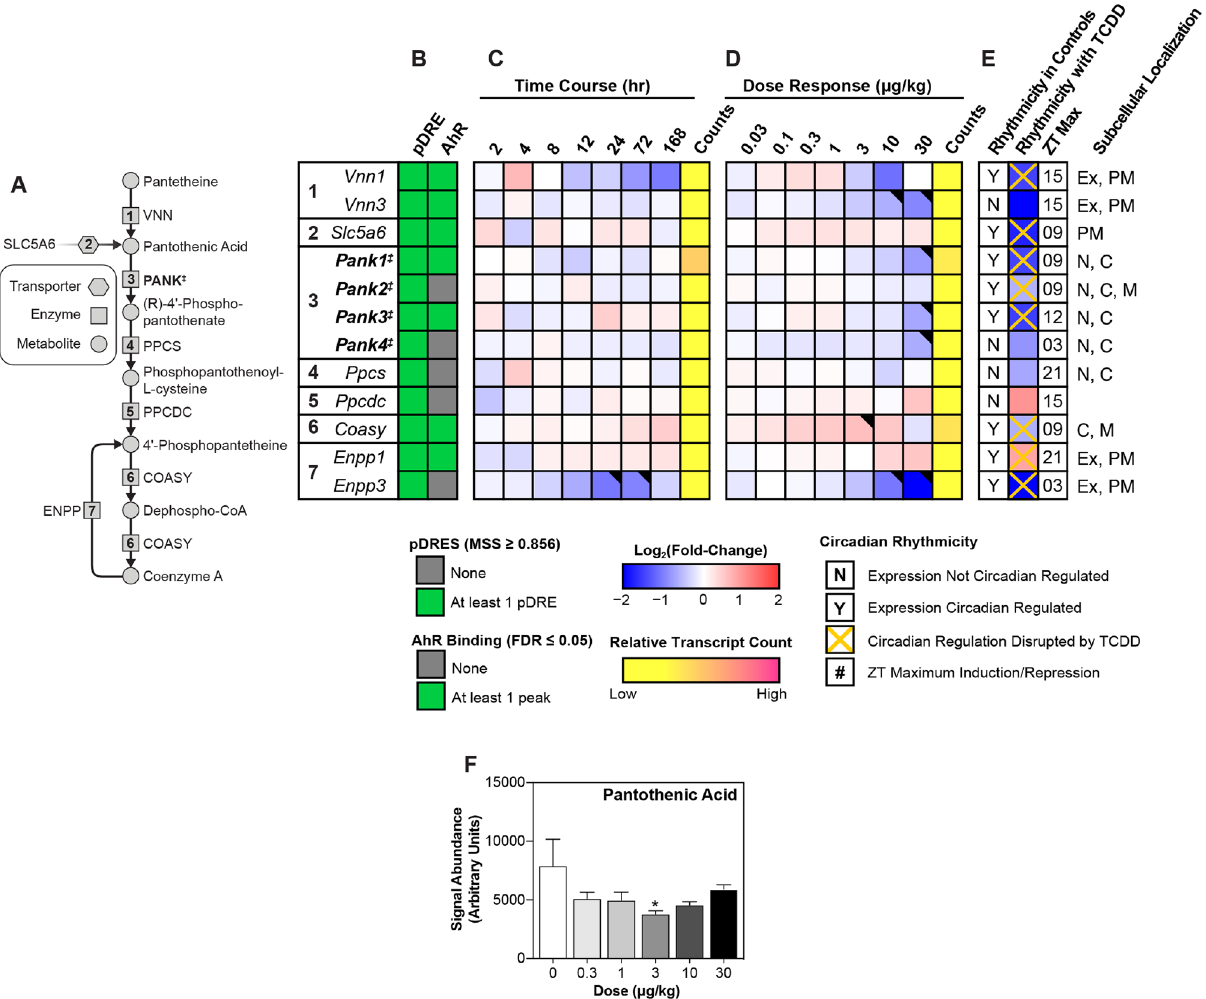
Figure 3. Biosynthesis of coenzyme A (CoA). Differential gene expression pertaining to CoA biosynthesis was assessed using RNA-seq. ( A ) The CoA biosynthesis pathway is shown with regulated steps denoted